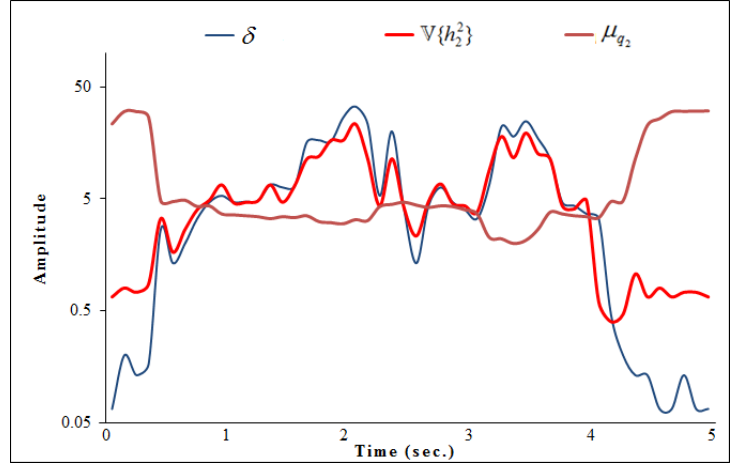
Figure 2. Discriminant components